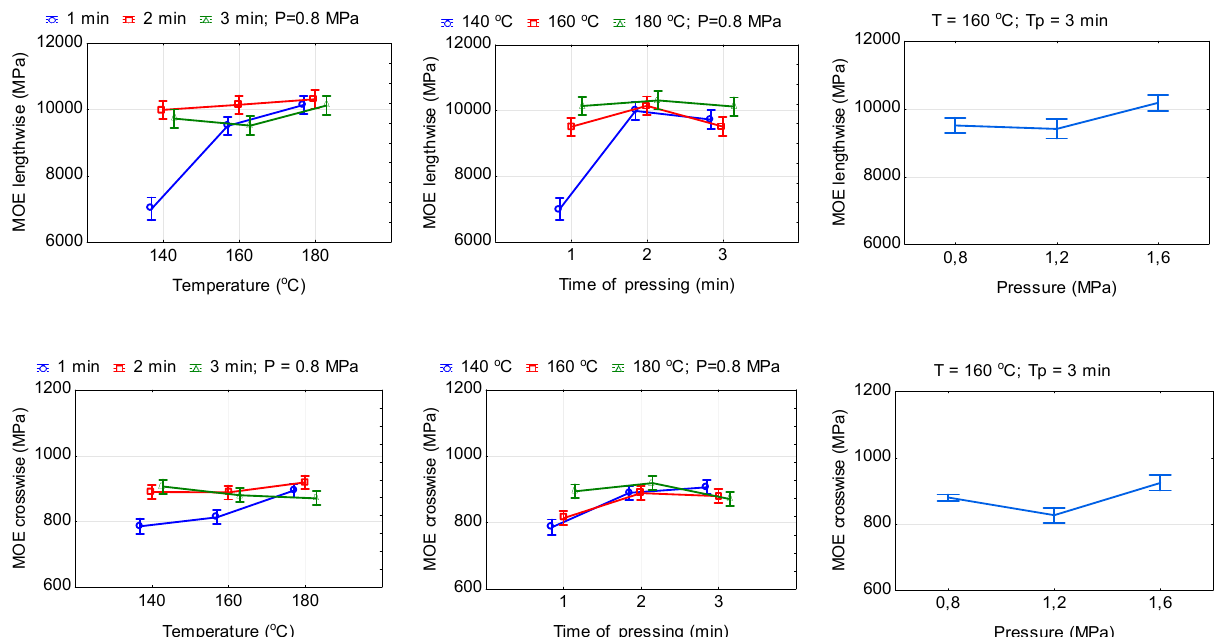
Figure 7. The relationship between the modulus of elasticity in bending and hot-pressing parameters (lengthwise = in parallel and crosswise = in perpendicular directions).